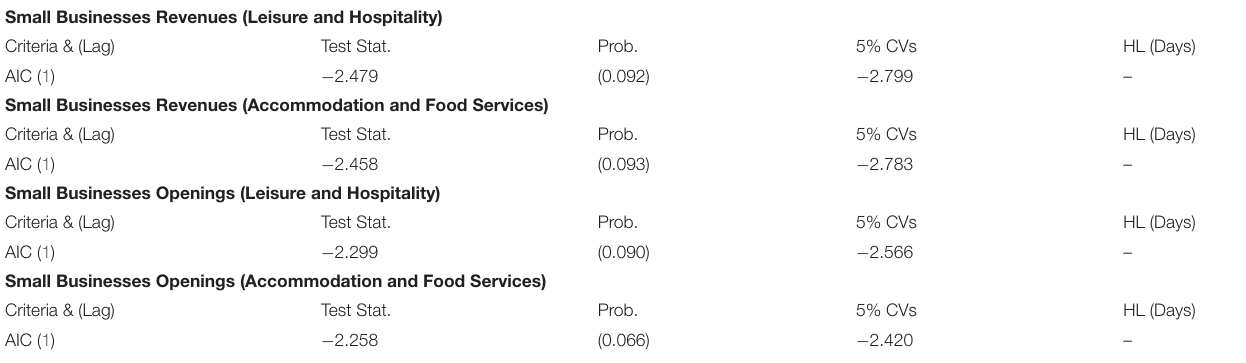
TABLE 1 | Results of the bootstrap unit-root test for a random walk with drift (small businesses revenues and openings in different sectors, national level). Small Businesses Revenues (Leisure and Hospitality) Criteria & (Lag) Test